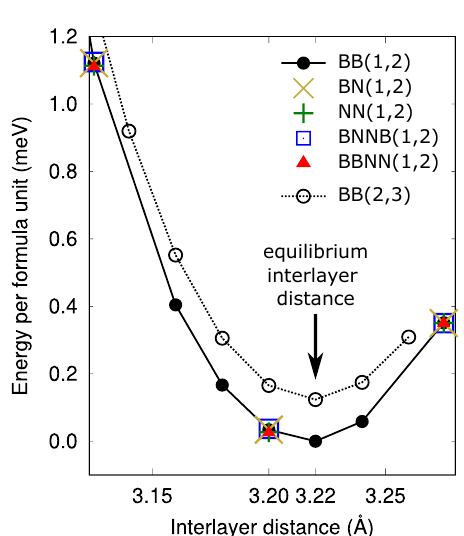
Figure 10: Total energy calculation of the five stackings in the (1,2) supercell as a function of the interlayer distance h . The BB(1,2) is the full black line with black bullets and the BB(2,3) is the dotted line with empty circles. The other (1,2) stackings are superimposed to the BB(1,2) curve almost exactly and are reported with different colors and symbols.